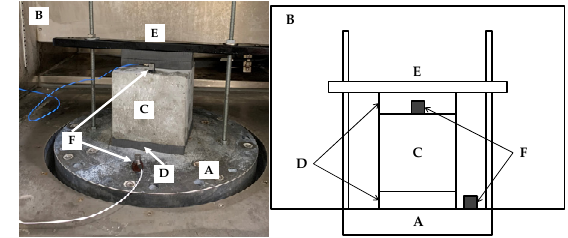
Figure 4. The measurement system used in this study (a) vibration system, (b) climate chamber, (c) concrete block, (d) test specimen, (e) fixtures and (f) acceleration